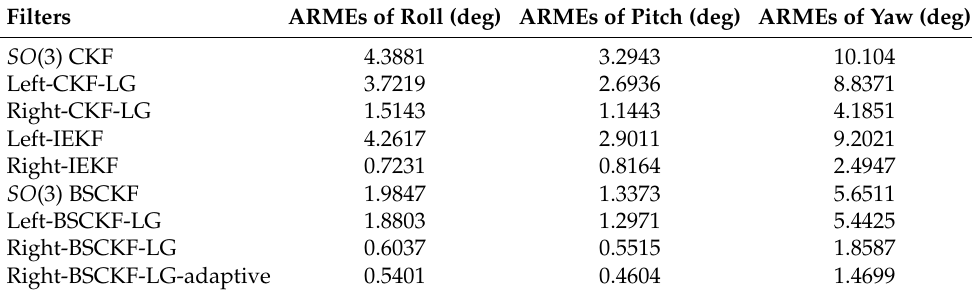
Table 2. ARMSEs of Euler angles in Case 2.